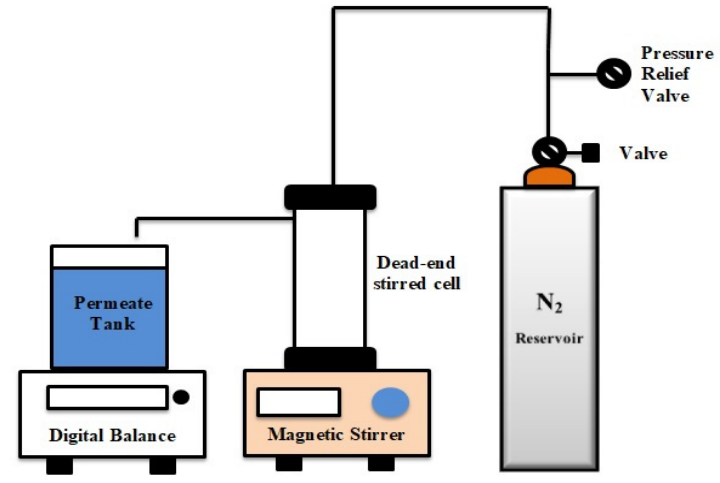
Figure A1. Schematic diagram of dead-end filtration experimental setup.